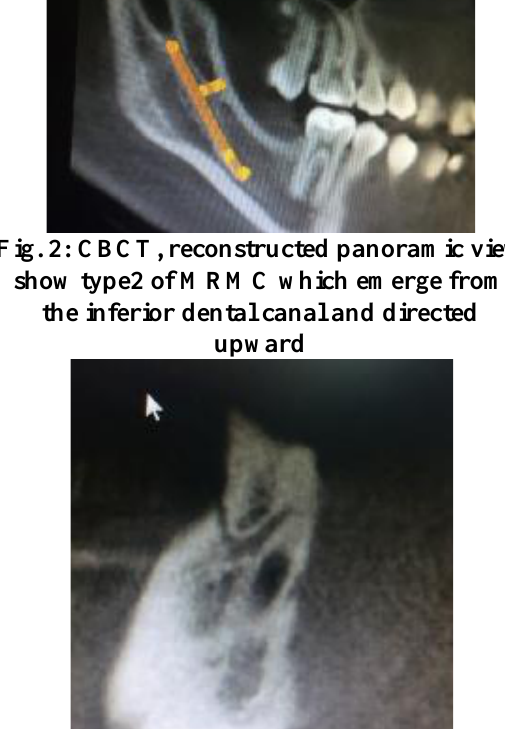
Fig. 3: CBCT sagittal view show type1 of MRMC which emerge from the inferior dental canal and directed to retromolar area Oral Diagnosis